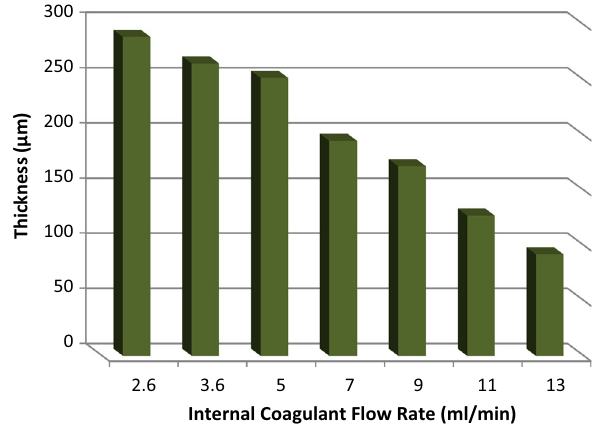
Fig. 4 Effect of ICFR on the hollow fiber thickness